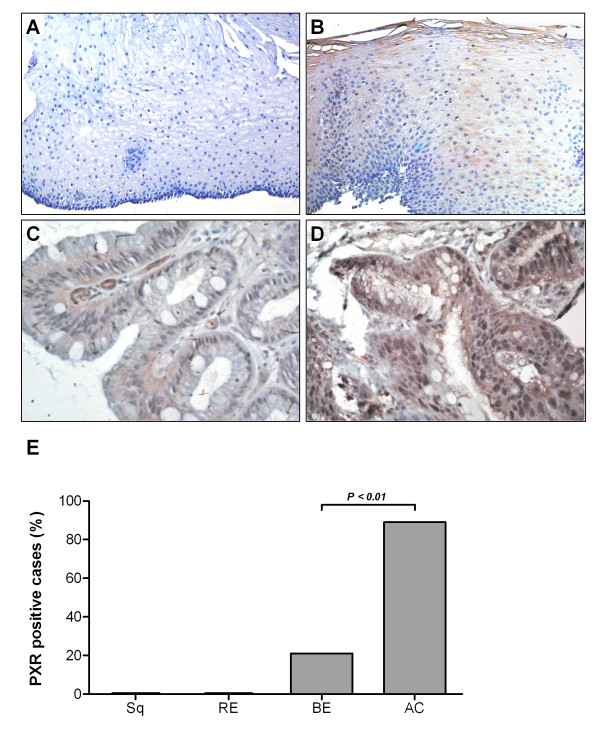
Result of PXR immunohistochemical staining on esophageal biopsy specimens. (A) Esophagus of healthy controls is lined by a stratified squamous epithelium and is negative for PXR (200×). (B) The esophageal mucosa of patients with reflux esophagitis is damaged and inflamed and demonstrates a weak signal for PXR (brown) in the cytoplasm of epithelium (200×). (C) Barrett's epithelium is characterized by a single layer of columnar epithelium with the presence of typical goblet cells. Cytoplasmic as well as some nuclear PXR expression is observed (400×). (D) Cells of adenoma tissue show high levels of nuclear PXR expression (400×). (E) Quantification showed that the percentage of cases with more than 2% PXR-positive nuclei was significantly higher in EAC than in BE (P < 0.01).